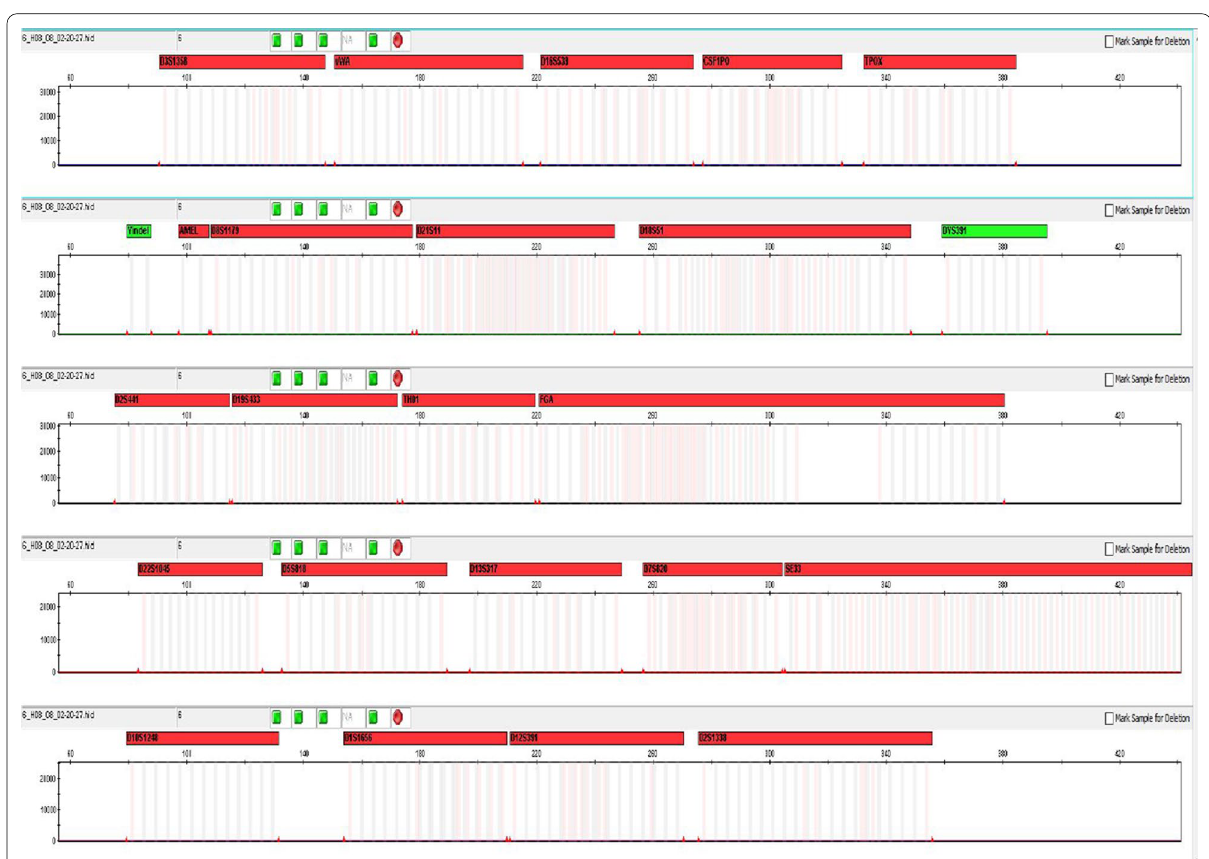
Fig. 10 DNA profile of blood stain in washed nylon fabric at 90 °C extracted by spin colon-based extraction method (QIAamp DNA Mini Kit)